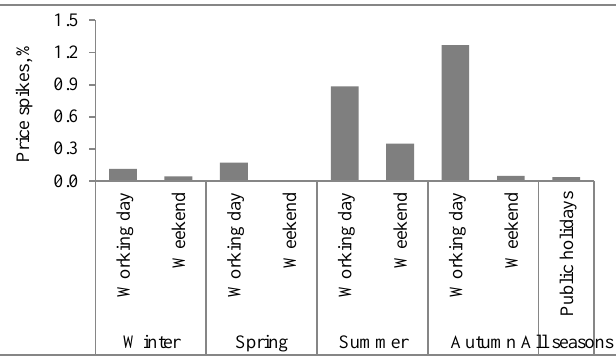
Fig. 6. Electricity price spikes in the Latvian day-ahead market (calculated by the authors). Electricity price is spiking in Latvia. All prices that are below 6.26 EUR/MWh and higher than 89.33 EUR/MWh are considered to be price spikes. In Latvia, price spikes mean very high prices. They were present for 2.92 % of the time span under consideration. Very low prices were absent in Latvia. Price spikes usually form in summer and autumn, encompassing 1.23 % and 1.32 % of time,